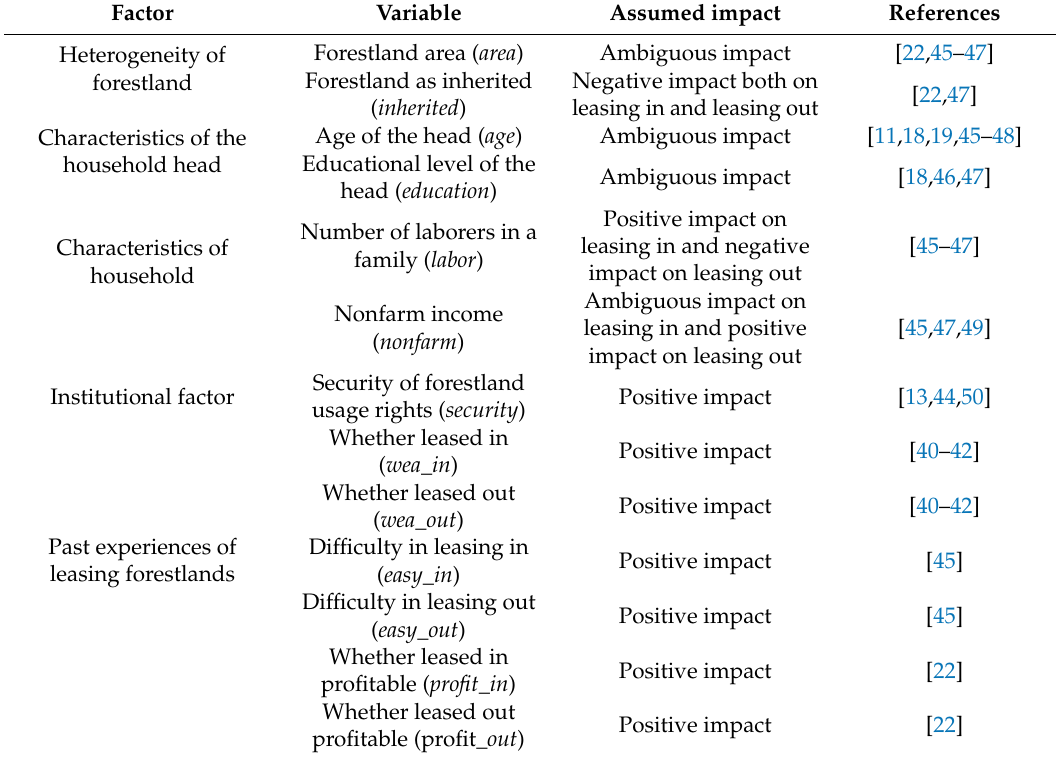
Table 1. Variables selections and assumed